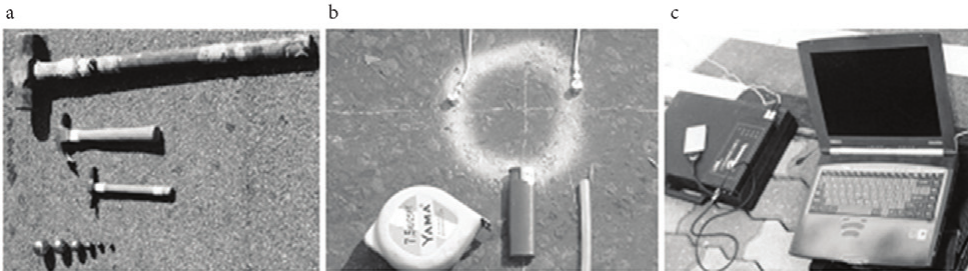
fig. 2. Instruments used in SASW measurement: a – impact sources; b – accelerometers; c – spectrum